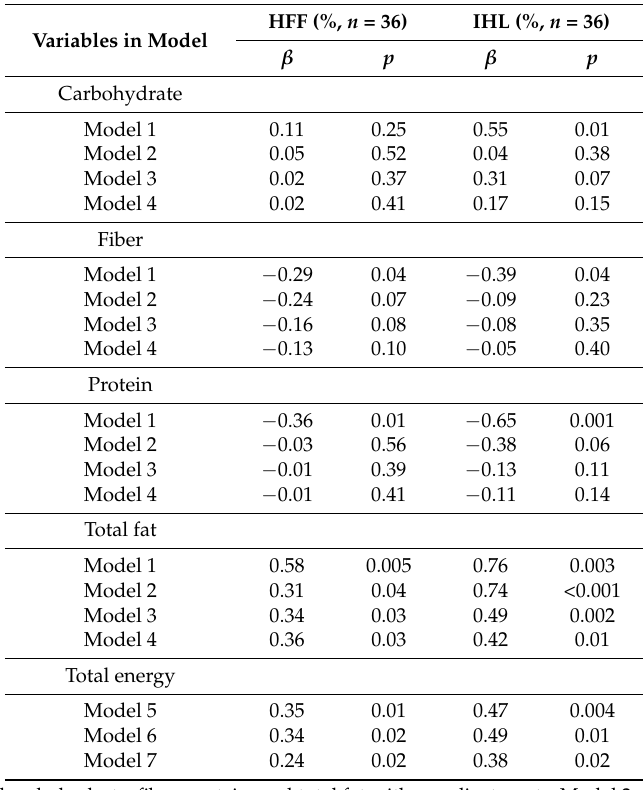
Table 3. Associations between dietary nutrient intakes and HFF and IHL.